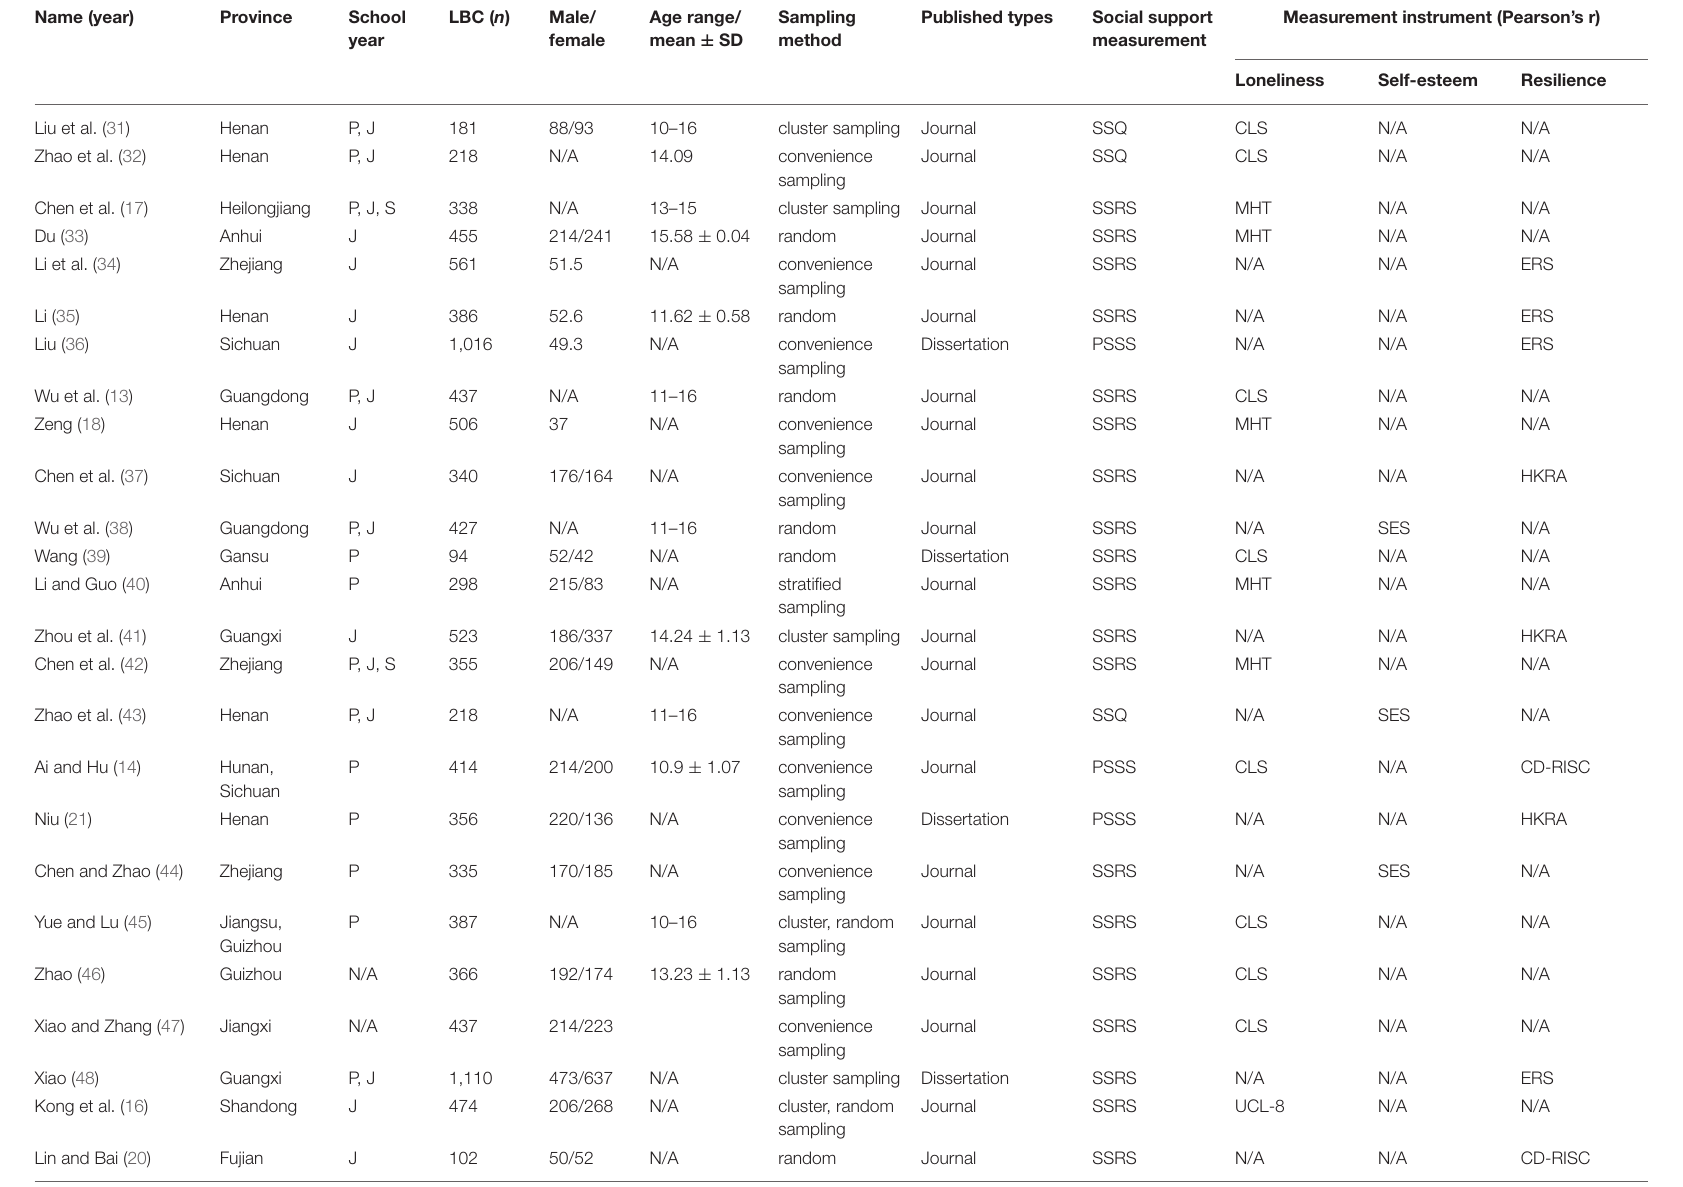
TABLE 1 | Characteristics of studies included in the